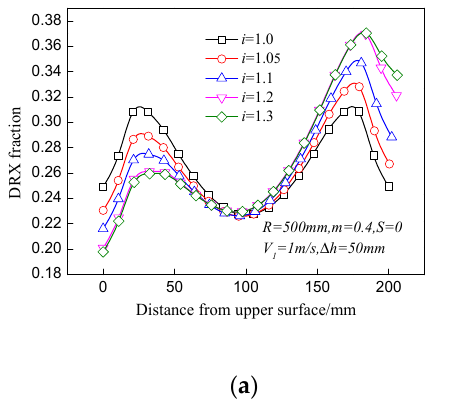
Figure 5. Effect of speed ratio on distributions of ( a ) DRX fraction and ( b ) average grain size in asymmetrical shear rolling.